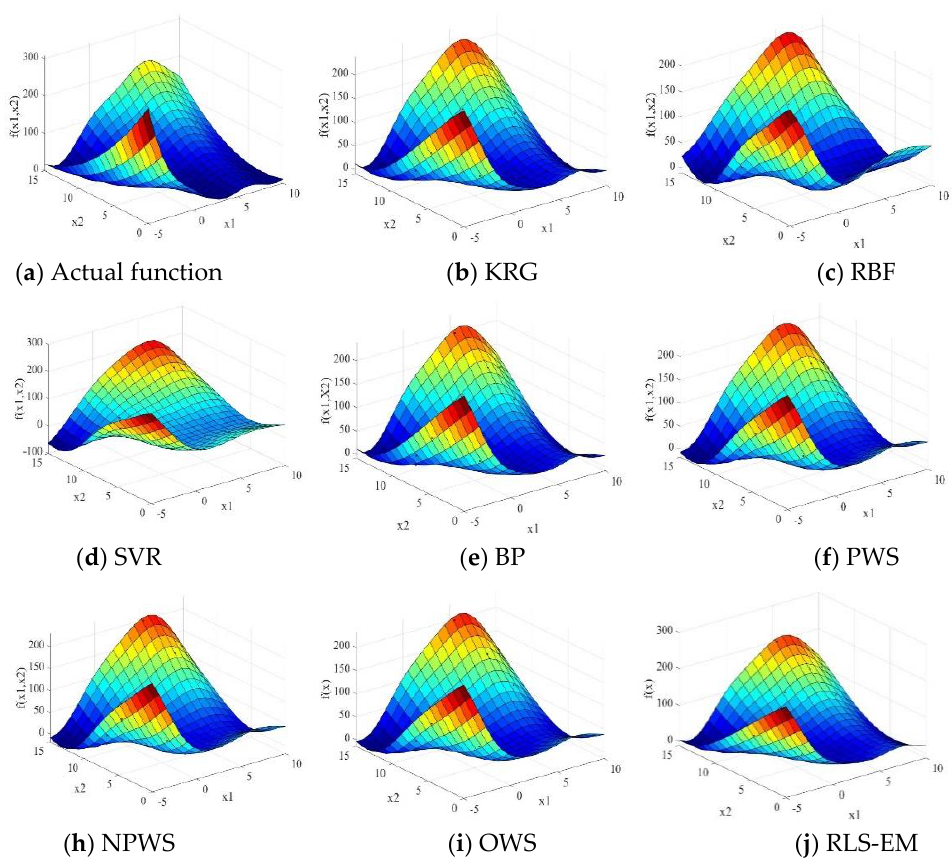
Figure 1. Surface plots of the Branin-Hoo function.